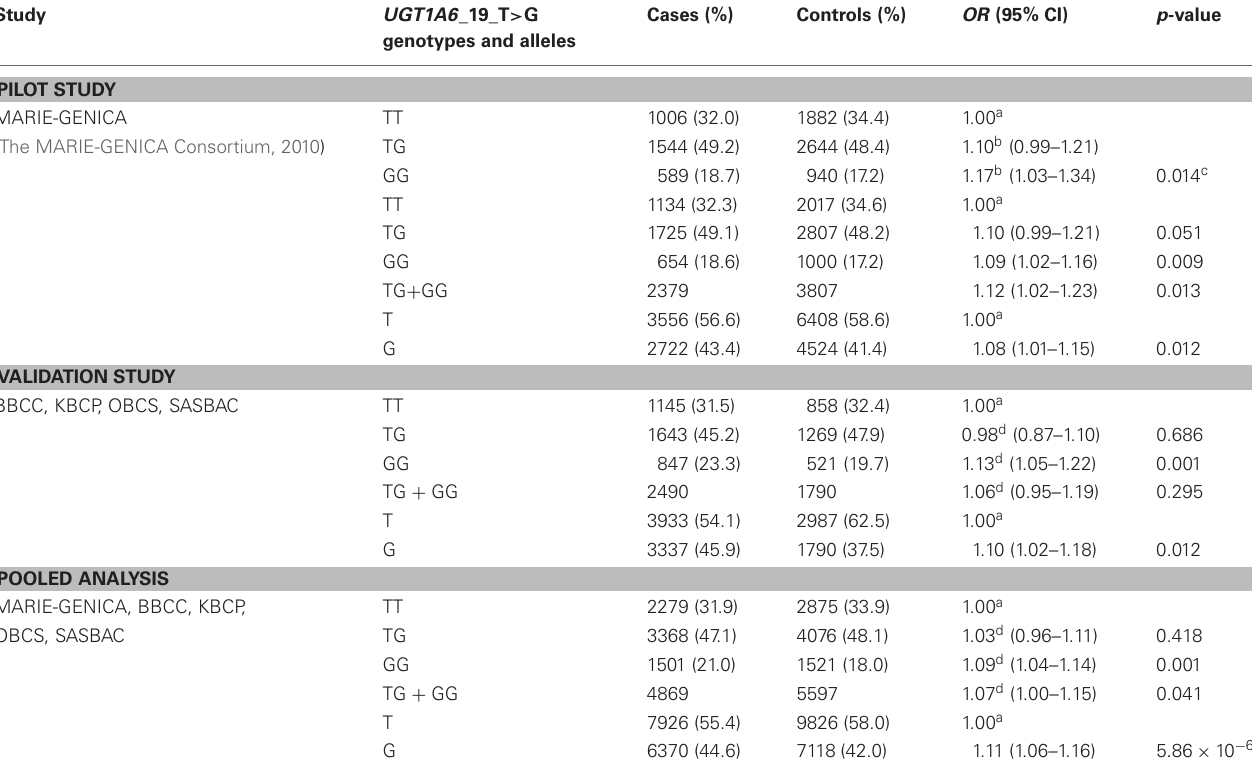
Table 2 | Association of UGT1A6 _19_T > G with breast cancer